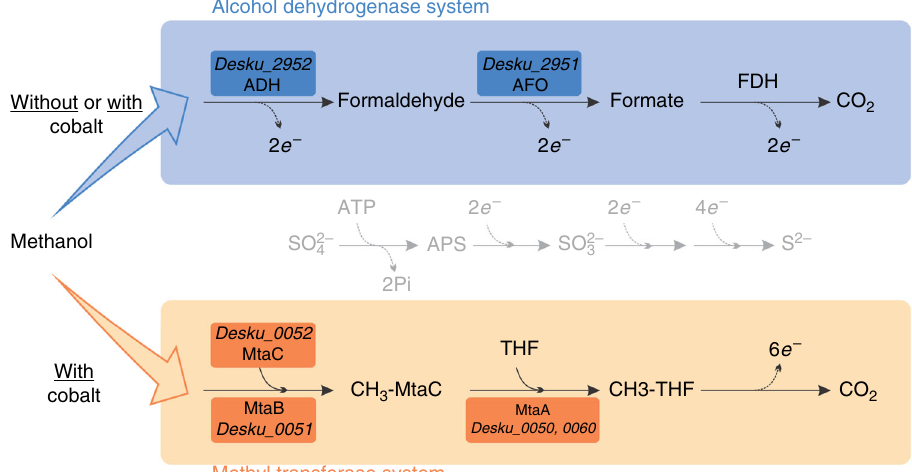
Fig. 2 Hypothesized methanol metabolism pathways in D. kuznetsovii . Methanol is oxidized to CO 2 by an alcohol dehydrogenase (ADH), aldehyde ferredoxin oxidoreductase (AFO), and a formate dehydrogenase (FDH). When cobalt is present in the environment a second concurrent methanol- oxidizing pathway is induced and part of the methanol is methylated to methyl-tetrahydrofolate (CH 3 -THF). Subsequently, CH 3 -THF is oxidized to CO 2 generating the same amount of electrons. Locus tag numbers are indicated for boxed enzymes